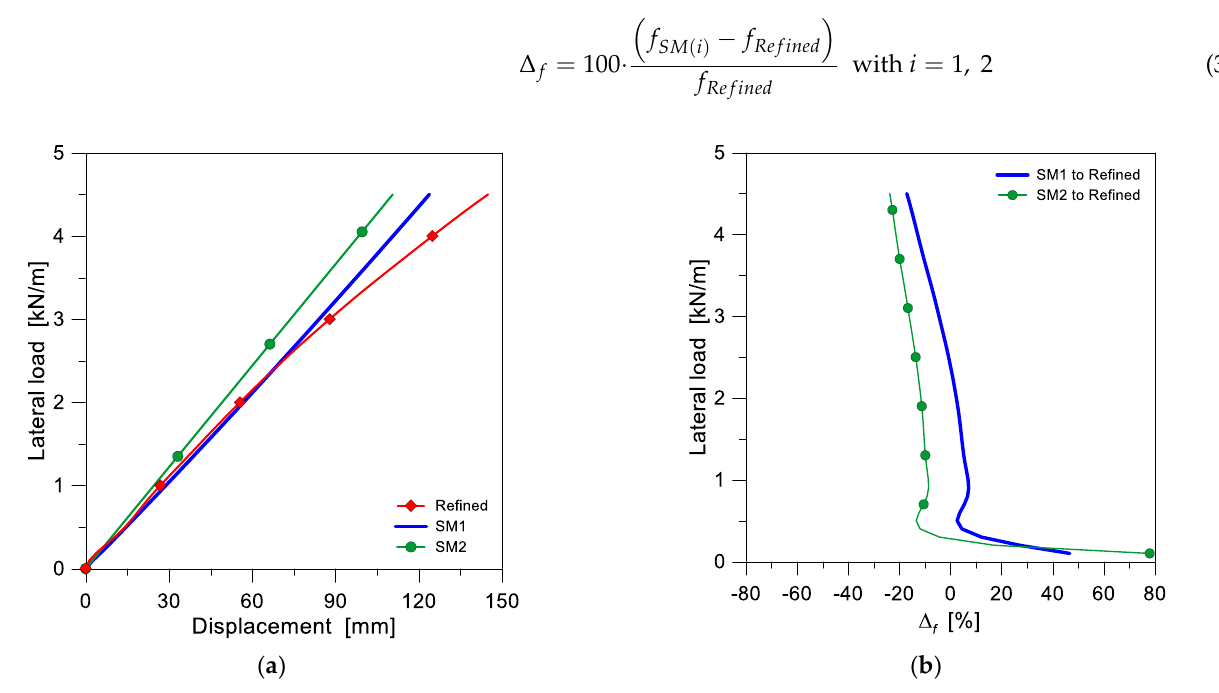
Figure 13. Numerical analysis of Refined, SM1, and SM2 simplified models under quasi-static lateral load ( P = 4.5 kN/m) at the top edge of glass (ABAQUS): ( a ) top lateral displacement and ( b ) calculated percentage scatter of SM to Refined models (Equation (32)).